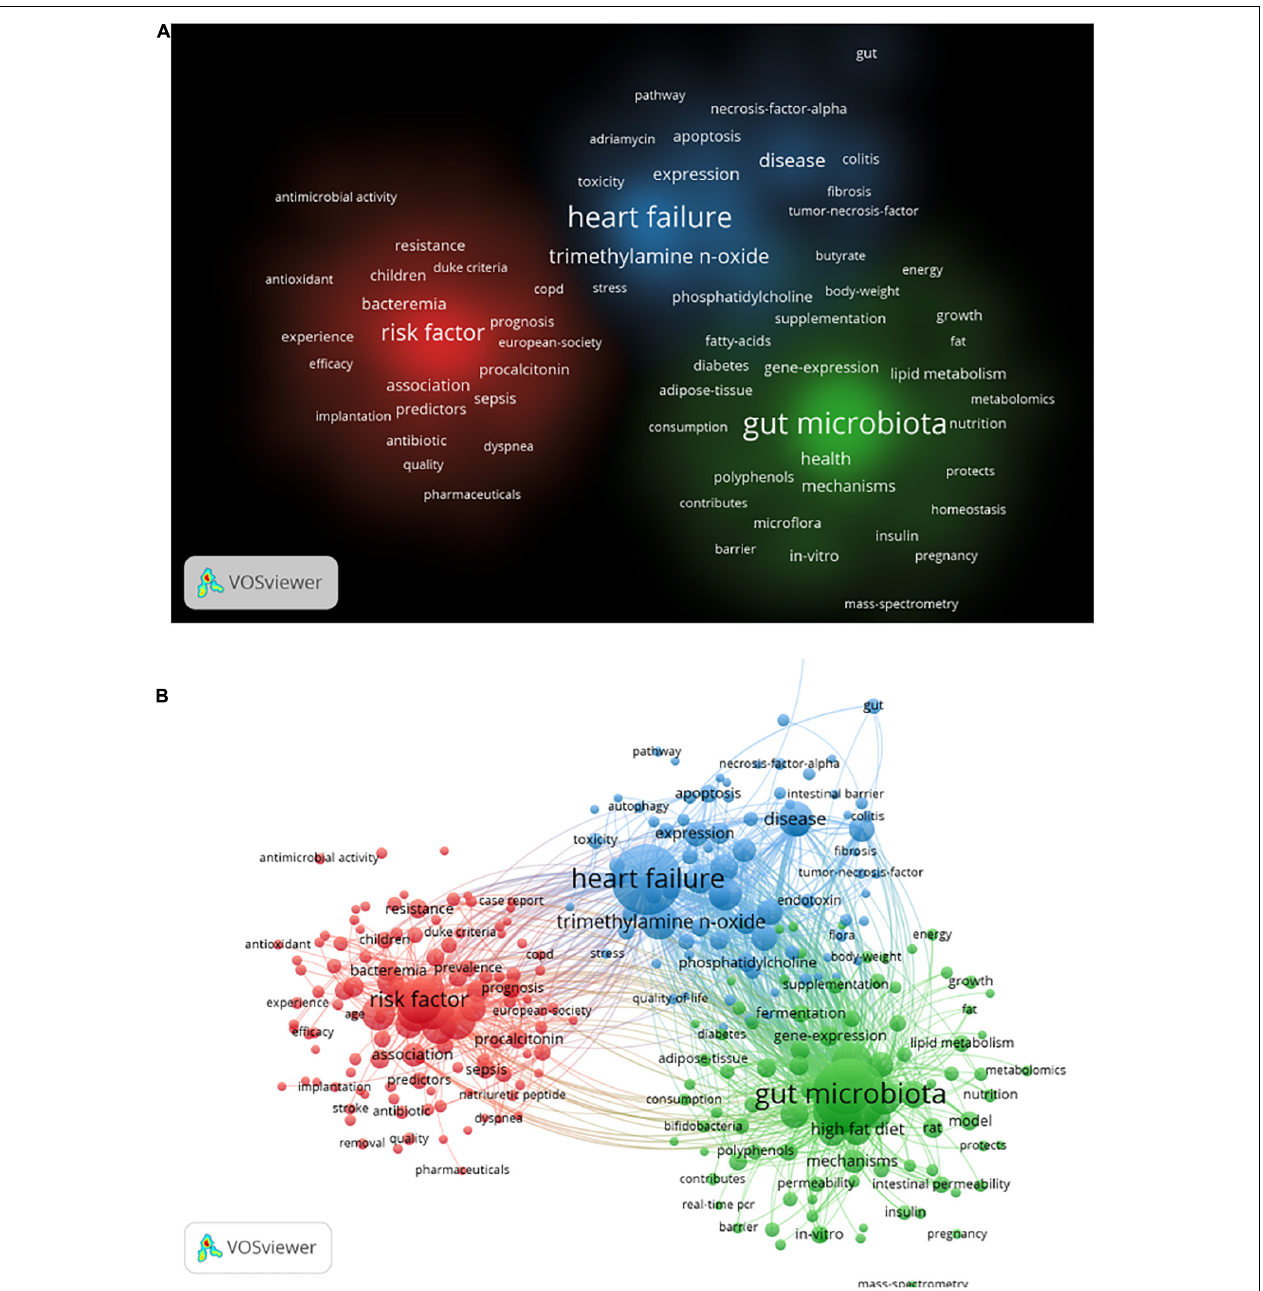
FIGURE 6 | Visualization of keyword co-occurrence analysis from 2006 to 2021 based on the VOS viewer software. (A) The density visualization map, and the depth of the color was positively correlated with the occurrences of keywords. (B) The network visualization map, all the keywords could be clustered into three